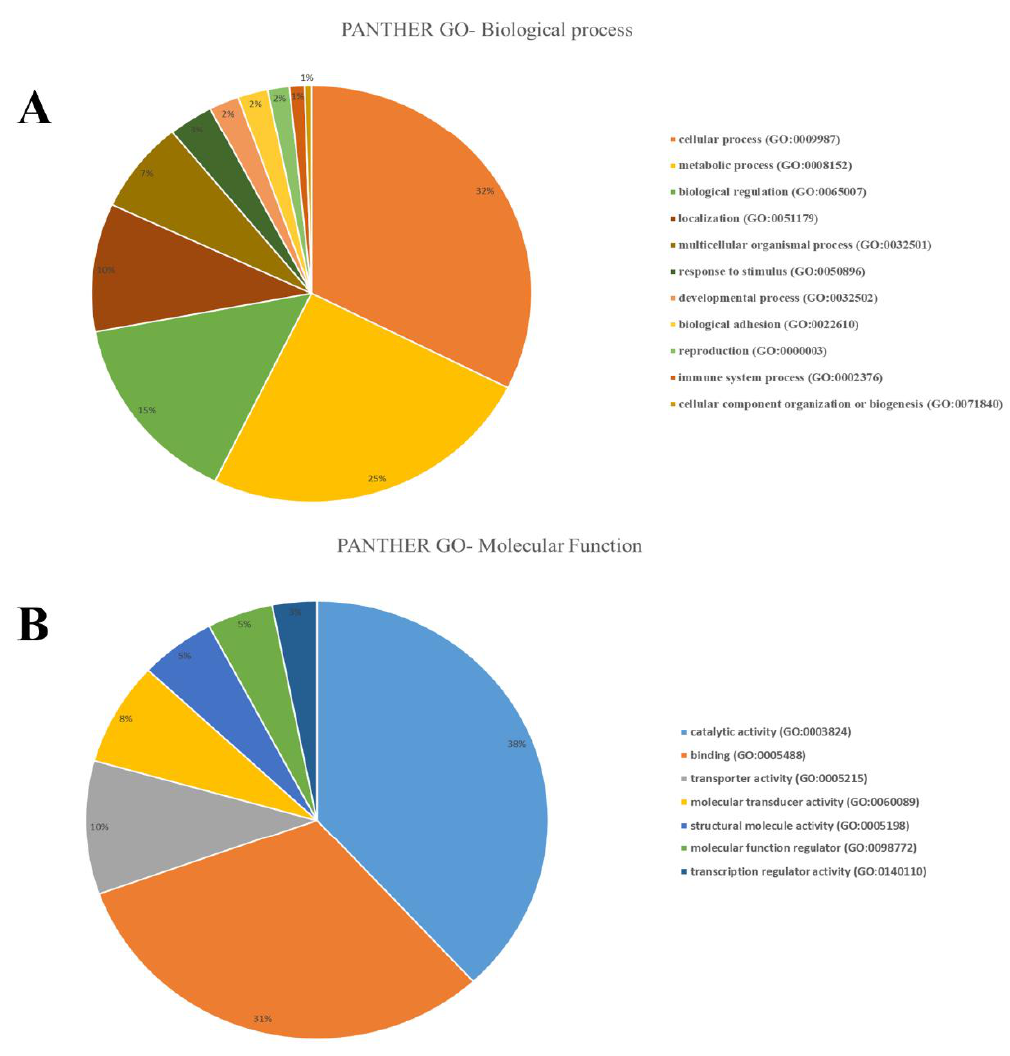
Figure 2. ( A ) The PANTHER GO-Biological process based on selection genes, showing the percent of gene hit against total # Process hits. ( B ) The PANTHER GO-Molecular Function based on selection genes, showing the percent of gene hit against total # Function hits.